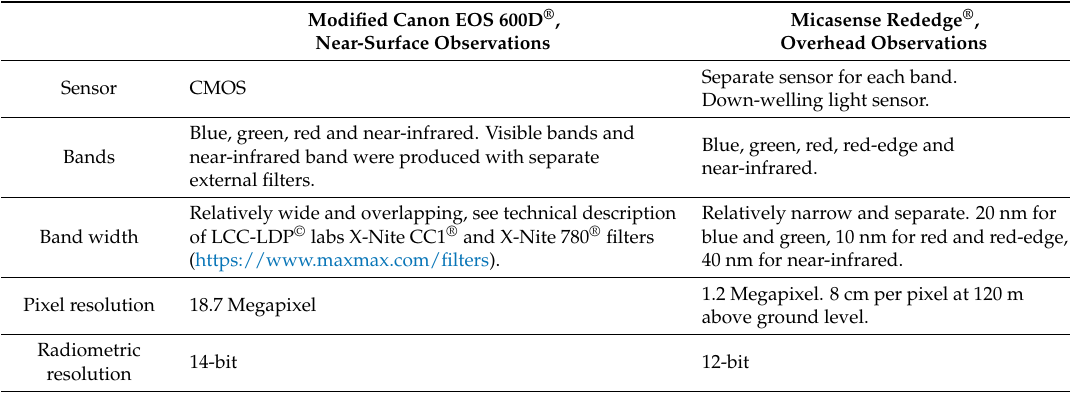
Table 1. Technical characteristics of the near-surface and overhead cameras.